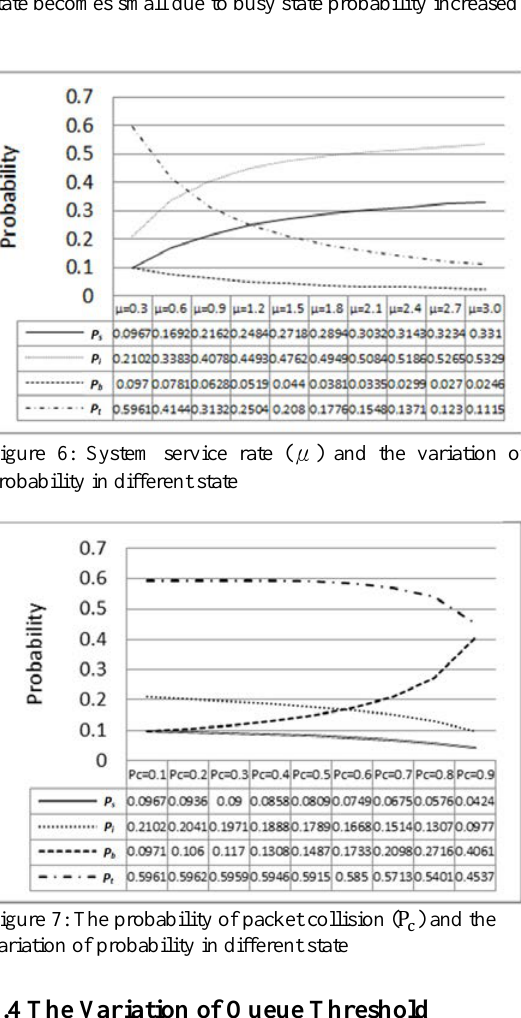
Figure 7: The probability of packet collision ( variation of probability in different state